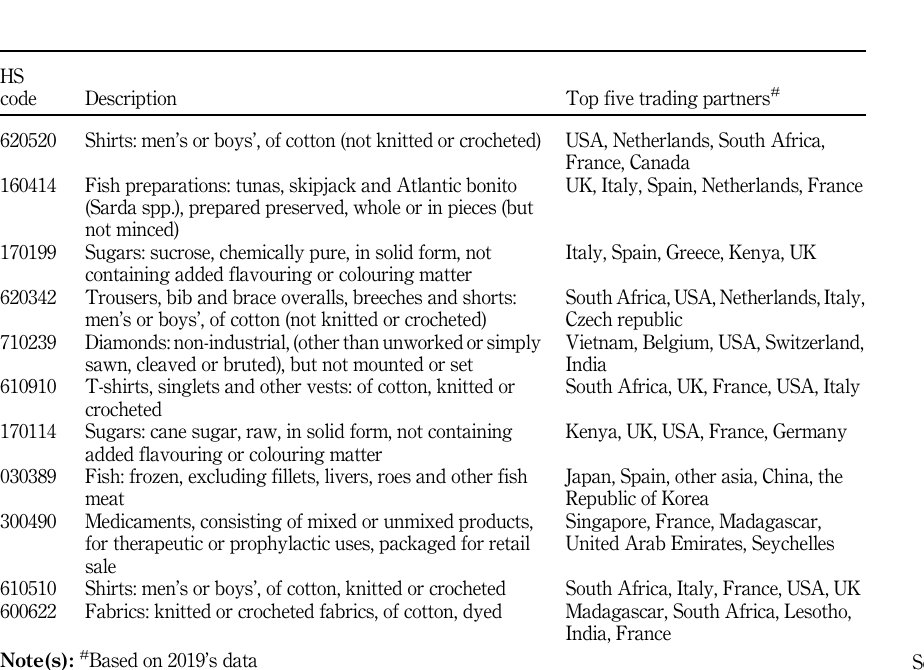
Table A2. Sector and top